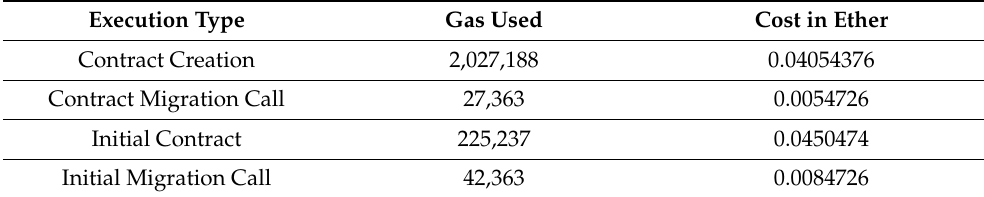
Table 2. Analyse of the costs associated with data